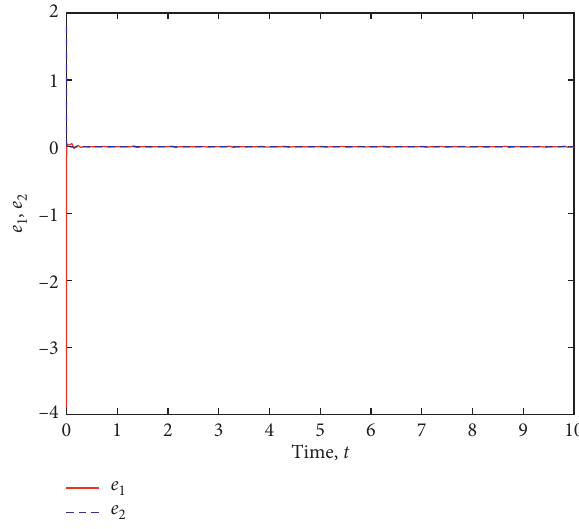
Figure 7: e ,e are asymptotically stable. Figure 8: The phase portrait of master subsystem and the slave 3 4